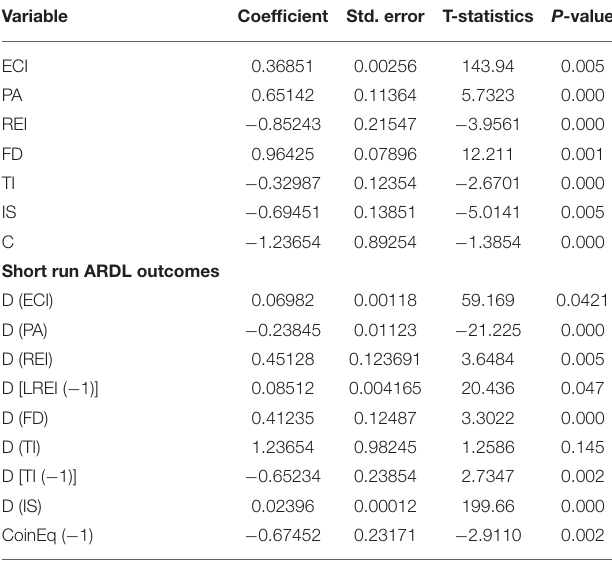
TABLE 7 | Short run and long run ARDL